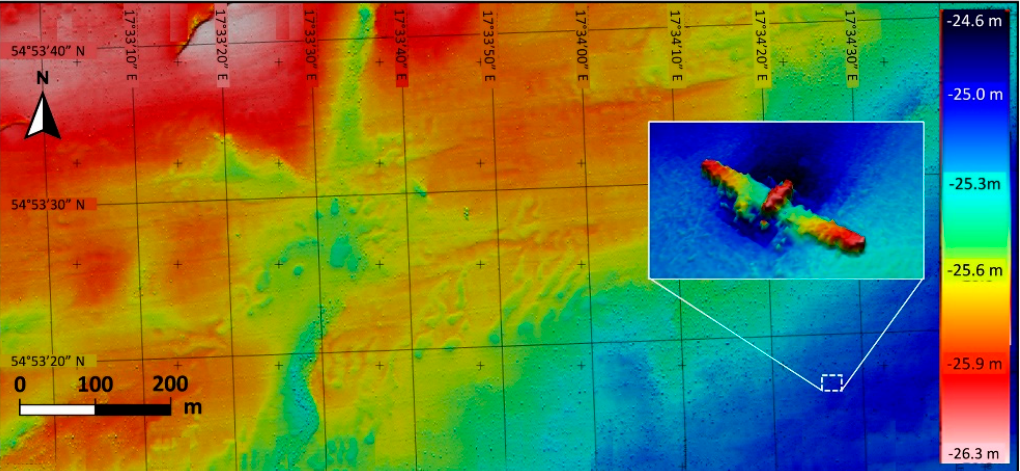
Figure 5. Grid of bathymetric data and location of the wreck prepared based on multibeam echo sounder measurements.